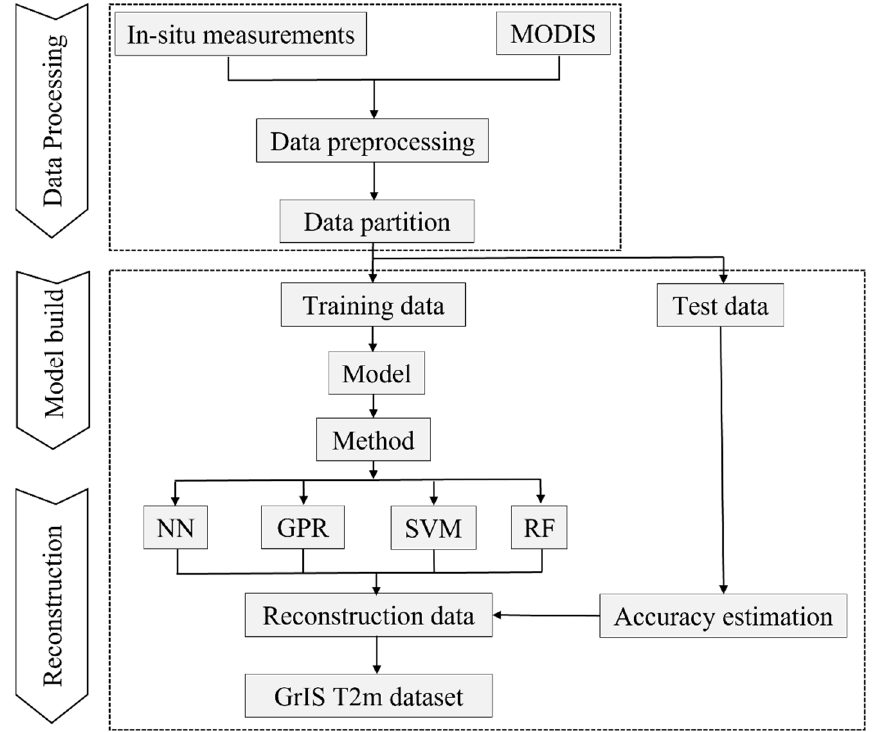
Figure 4. The GrIS T2m reconstruction process based on four machine learning methods.